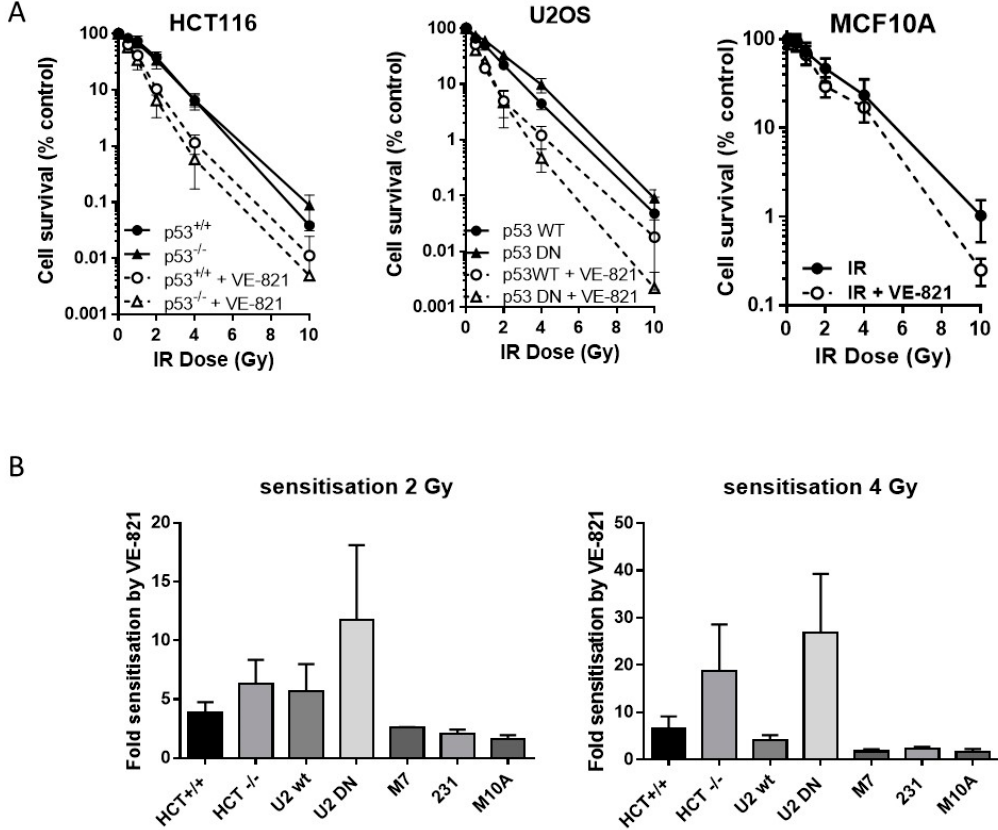
Figure 3. ATR inhibition increases radiosensitivity, irrespective of p53 status. ( A ) Survival of HCT116, U2OS or MCF10A cells exposed to increasing doses of irradiation in the presence of 1 µ M VE-821 (open circles, dashed line) or a vehicle control of 0.1% DMSO (filled circles, solid line) for 24 h, then reseeded at low density for colony formation. Data are mean ± standard deviation from three separate experiments; ( B ) the surviving fraction at 2 Gy and 4 Gy was determined for paired and unpaired cell lines and the fold-sensitisation by VE-821 calculated from the ratio of the survival in the presence and absence of VE-821 for each independent experiment. HCT = HCT116, U2 = U2OS, M7 = MCF7, 231 = MDA-MB231, and M10A = MCF10A.